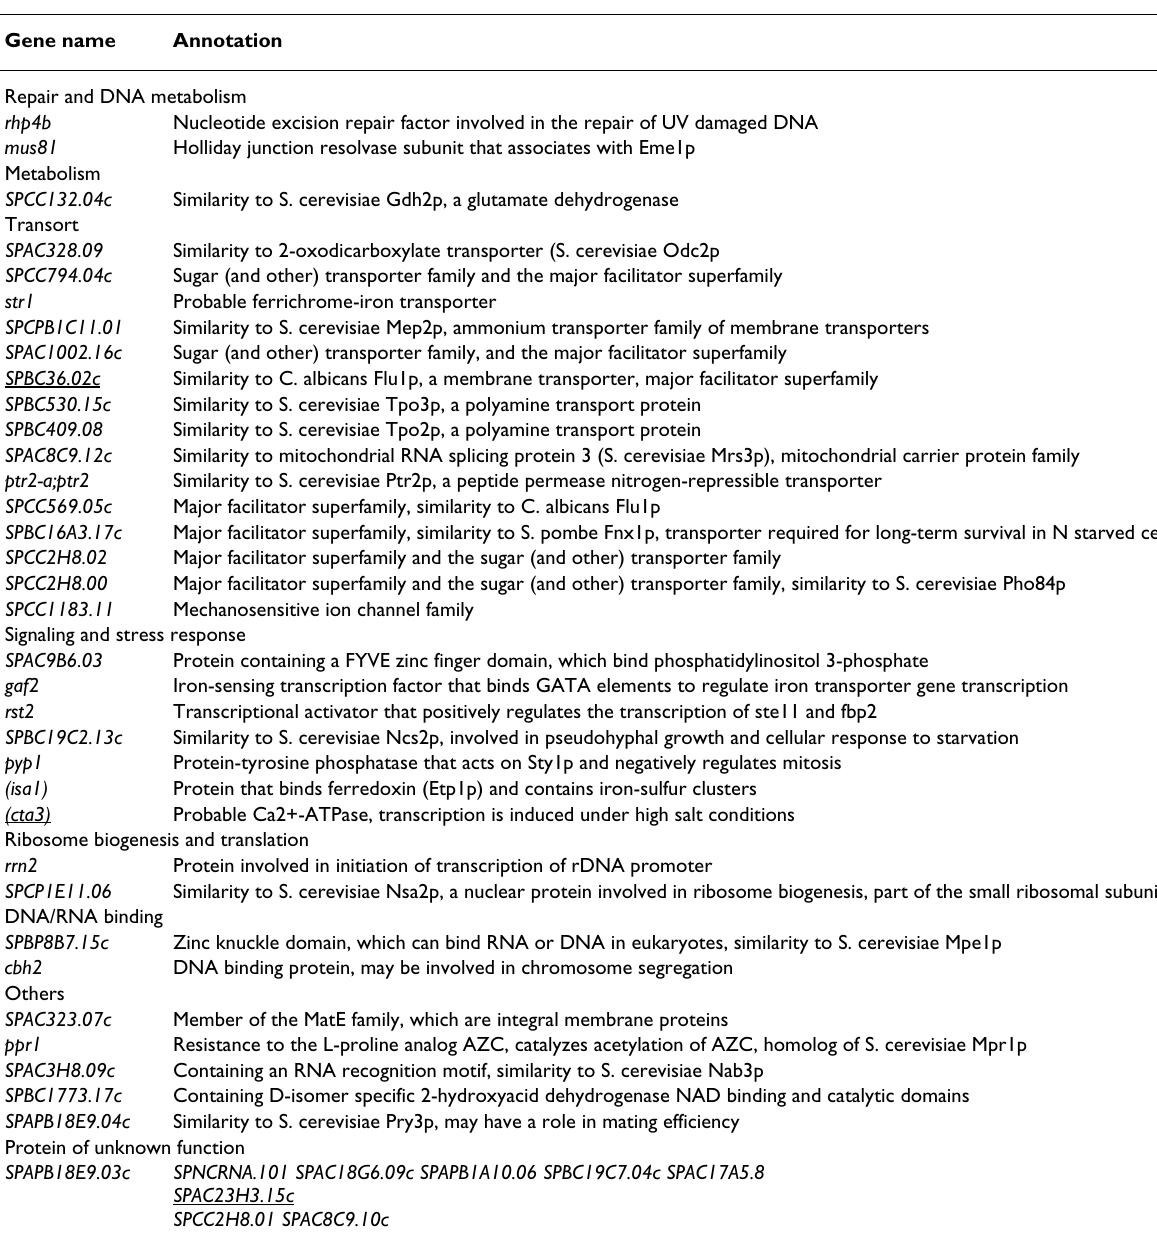
Table 3: UV-induced genes not present in the CESR at UV30 UV-induced genes not present in the